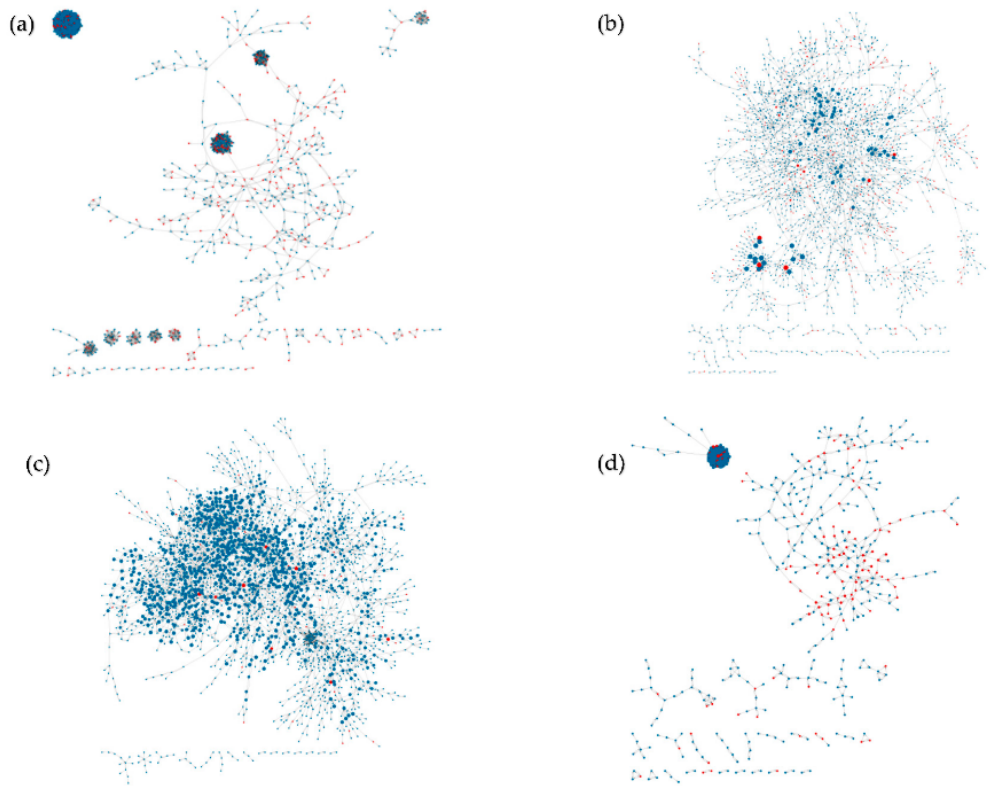
Figure 5. The consensus-based networks (step 1) were visualized in Cytoscape. Red-colored nodes are pathogenic; all other nodes are non-pathogenic. Node size is scaled by the node’s network influence. ( a ) Hepatocellular cancer, ( b ) gastric cancer, ( c ) Alzheimer’s disease, ( d ) breast cancer.